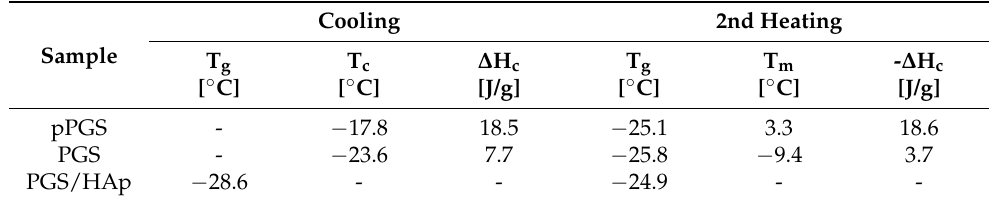
Figure 8. The cooling ( A ) and second heating ( B ) DSC curves of prepolymer pPGS and porous scaffolds PGS and PGA/HAp. Table 3. The thermal parameters of pPGS, PGS100 and PGS/HAp 75/25 evaluated from the cooling and second heating DSC curves.